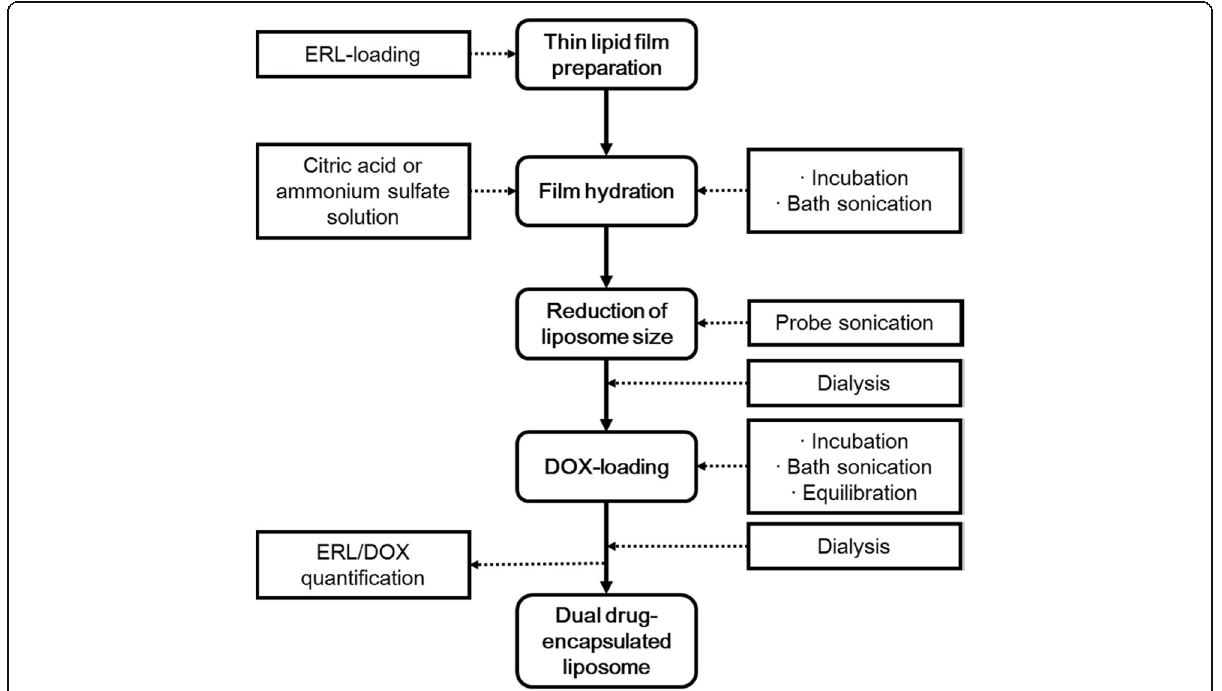
Fig. 1 Processes for preparation and characterization of dual drug-encapsulated